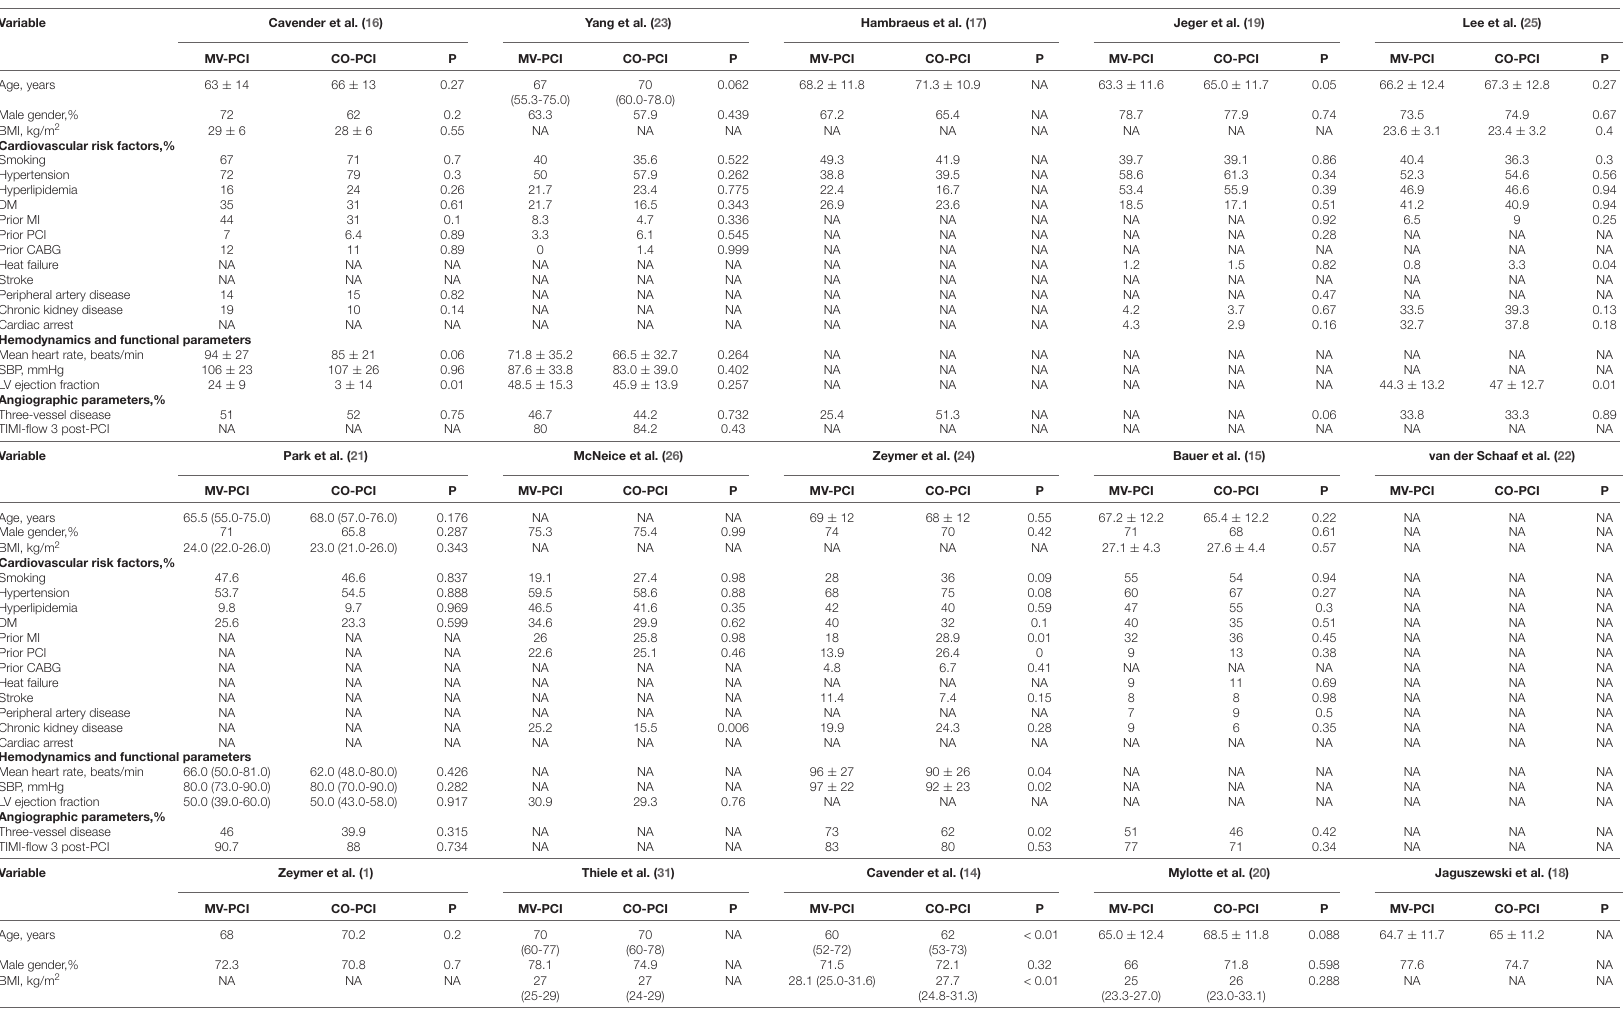
TABLE 2 | Baseline characteristics according to treatment strategy reported in the individual